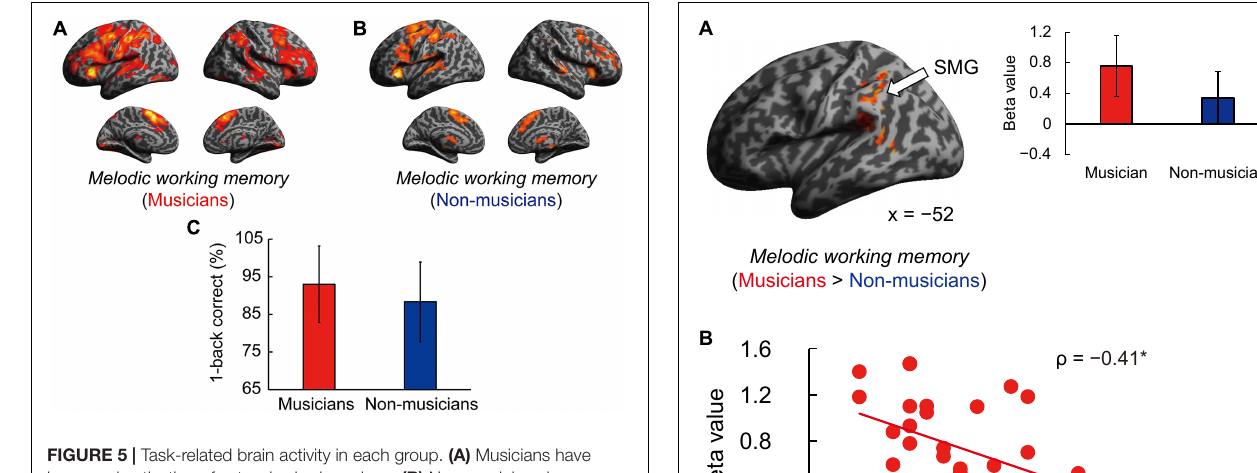
FIGURE 5 | Task-related brain activity in each group. (A) Musicians have increased activation of extensive brain regions. (B) Non-musicians have increased activation of limited brain regions. (C) There were no significant between-group differences in 1-back task performance. For significant between-group differences, see Supplementary Table 4 , Figure 6 , and the main text.